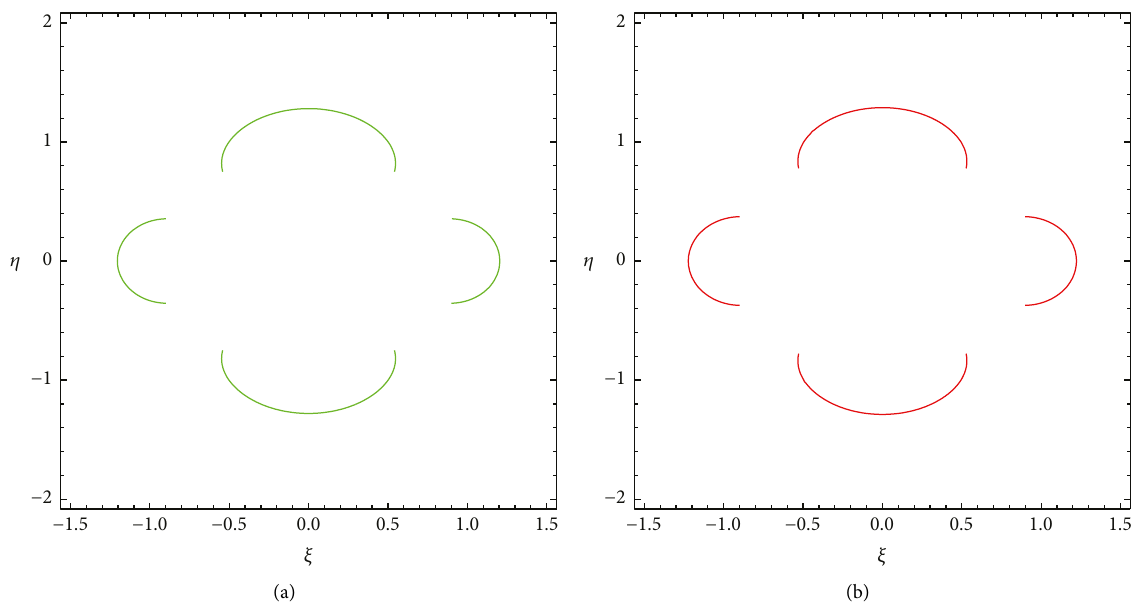
Figure 13: Condition (ii): projection of stability regions (a) b � 0 . 58 and a � 0 . 68; (b) b � 0 . 60 and a � 0 . 68.